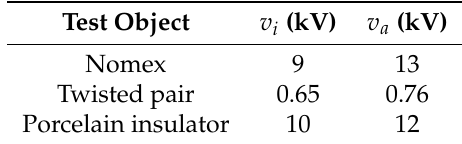
Table 4. Ignition and applied voltages for the test objects used.